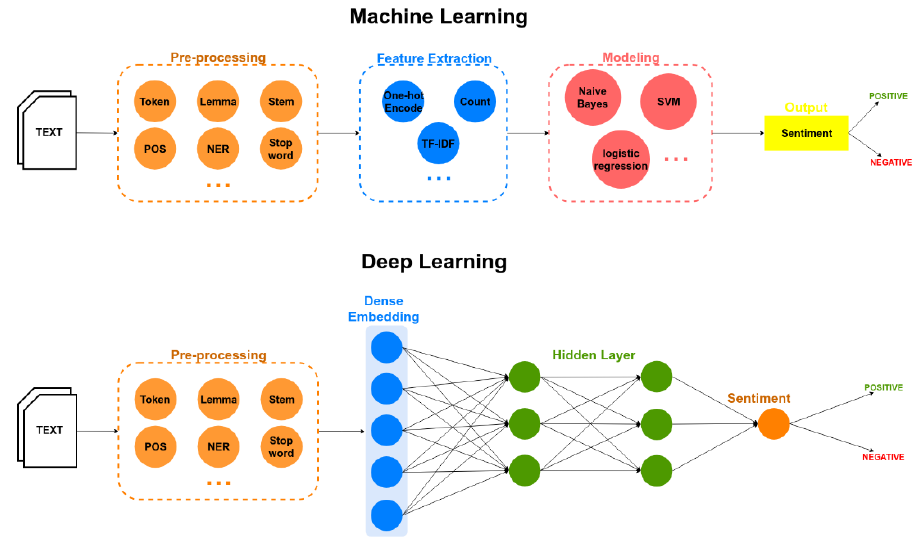
Figure 1. Differences between two classification approaches of sentiment polarity, machine learning (top), and deep learning (bottom). Part of Speech (POS); Named Entity Recognition (NER); Term Frequency-Inverse Document Frequency